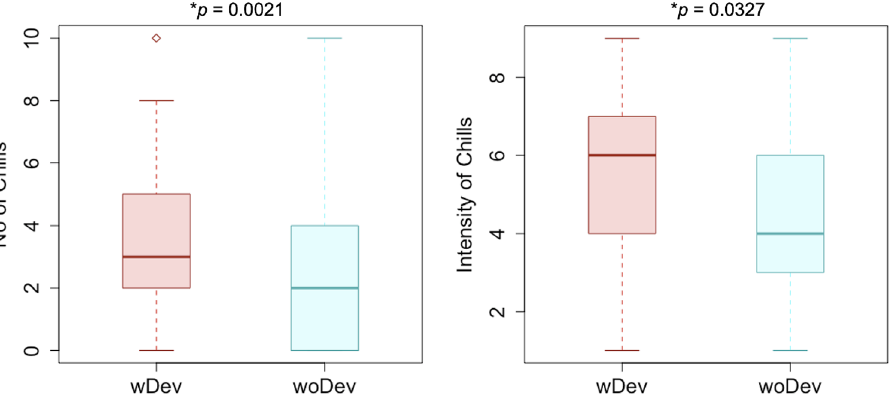
Figure 1. Number and Intensity of chills per conditions: participants wearing the device reported experiencing significantly greater number and intensity of chills during the experience with the device than during the experience without the